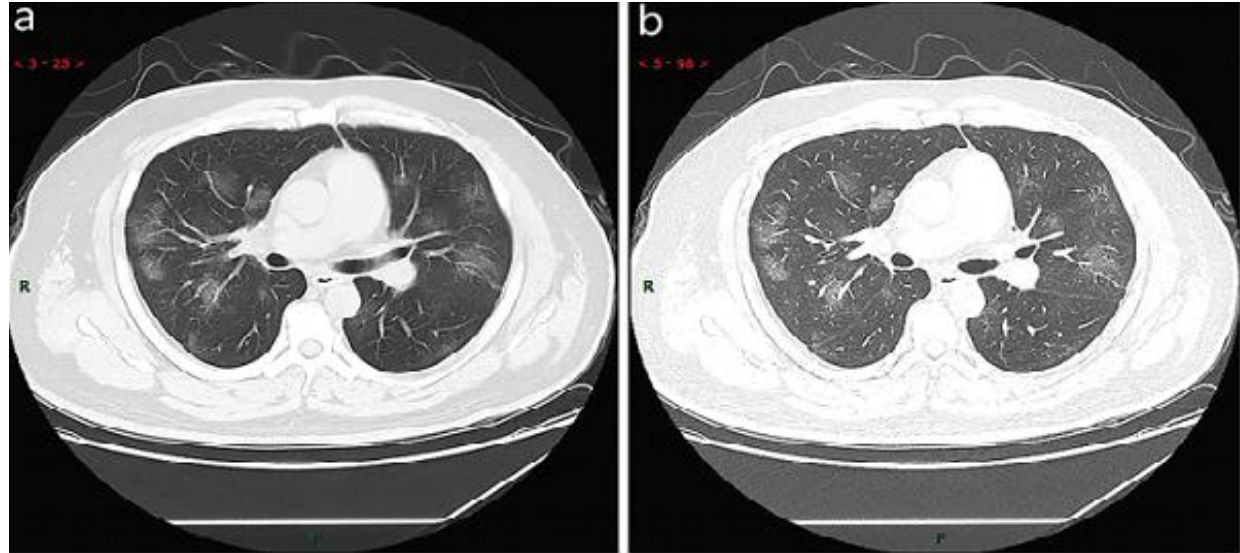
Figure 1: Typical CT imaging manifestation (case 1). A 38 years old male with fever without obvious inducement (39.3 ℃), dry cough and shortness of breath for 3 days. Laboratory test: normal white blood cells (6.35 × 10 9 /L), decreased lymphocytes percentage (4.1%), decreased lymphocytes count (0.31 × 10 9 /L), decreased eosinophil count (0 × 10 9 /L)), increased C-reaction protein (170.91 mg/L), increased procalcitonin (0.45 ng/ml). Imaging examination: multiple patches, grid-like lobule and thickening of interlobular septa, typical “paving stone-like” signs. a SL(Slice): 6 mm; b high-resolution computed tomography(HRCT). HRCT. high-resolution computed tomography. opacity in the basal segment of the left lower